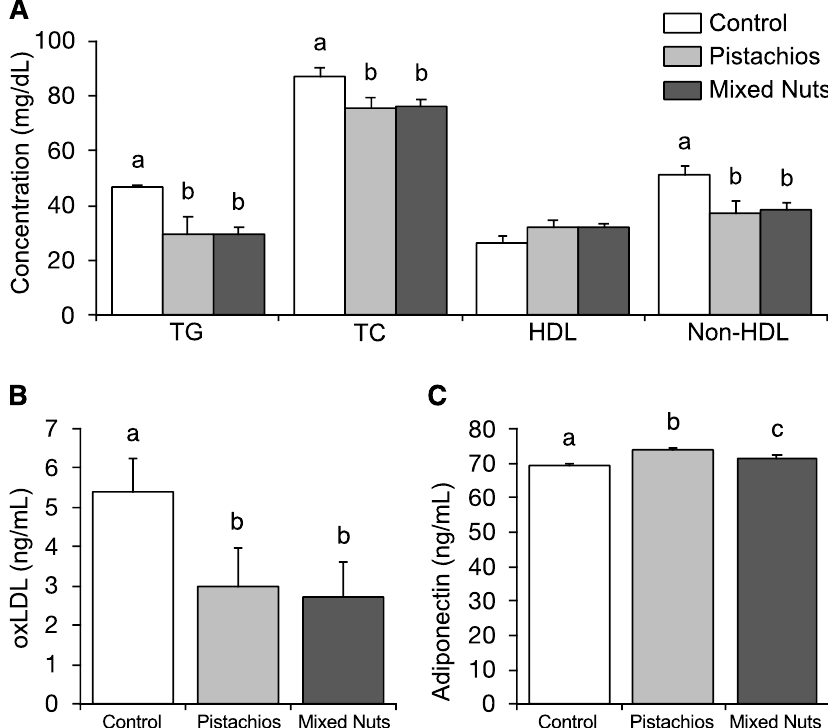
Figure 1. Effects of pistachios and mixed nuts on ( A ) serum lipids, ( B ) oxLDL, and ( C ) adiponectin. Bars represent means ± SE (standard error). Bars with different superscripts differ significantly at p < 0.05. TG, triglycerides; TC, total cholesterol; HDL, high-density lipoprotein; oxLDL, oxidized low-density lipoprotein.